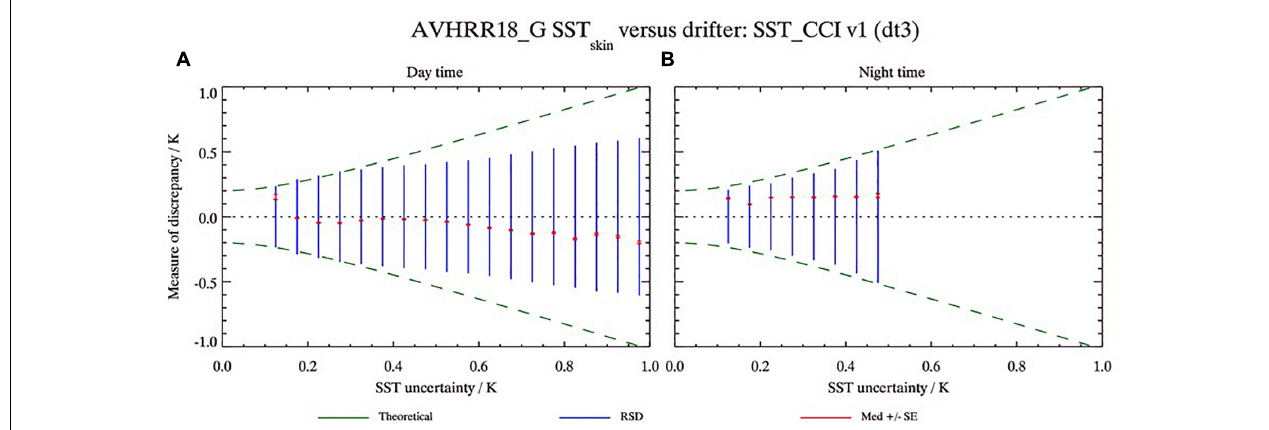
FIGURE 5 | Example of validation of an uncertainty model for an SST product. Here, SST uncertainty is defined per datum in an SST product, and varies over a range of 0.0–1.0 K. Matches to drifting buoys are binned in terms of the SST uncertainty, and the mean and standard deviation of the difference calculated per bin (indicated by the red and blue bars respectively). Accounting for an estimate of in situ uncertainty, the green dashed line is the envelope expected if the uncertainty estimates are accurate. As we can see from this example, the agreement at night time (A) is very good. However, for day time match-ups (B) the blue bars are within the theoretical envelope, indicating they are over estimated as the calculated standard deviation is smaller than the theoretical for much of the distribution. (Reproduced by permission under CC BY 4.0 from https://doi.org/10.6084/m9.figshare.7286168.v2).